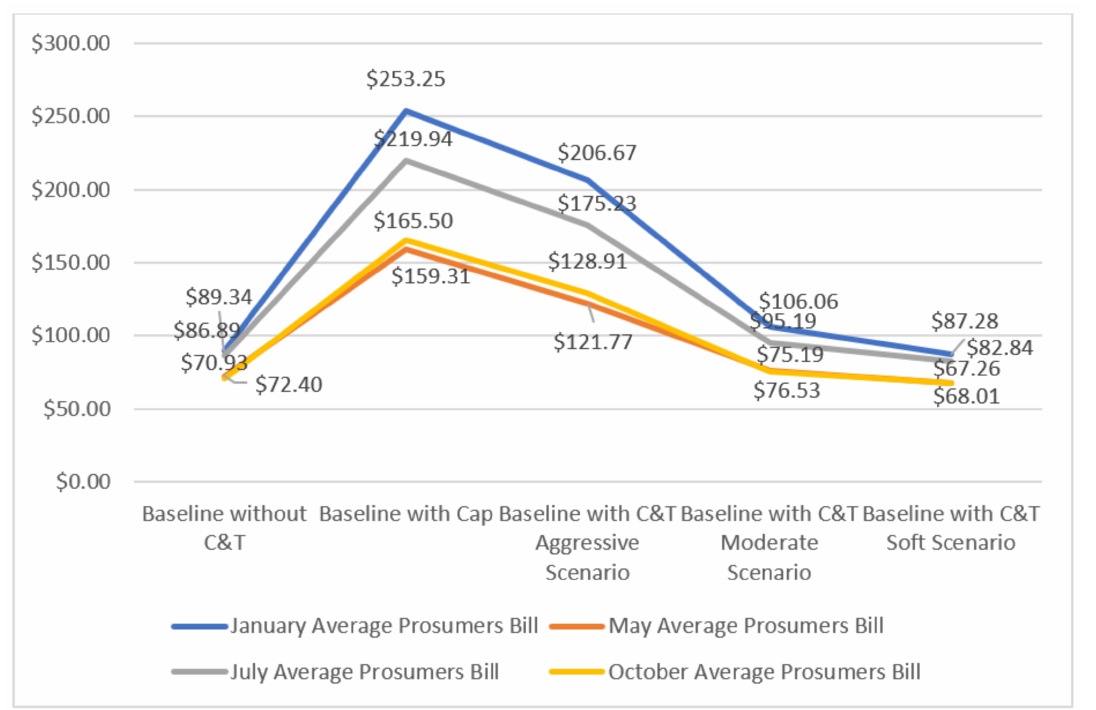
Figure 14. Average prosumer monthly bill in USD.